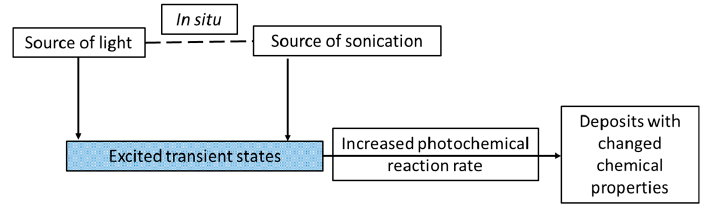
Figure 13. A schematic representation of the synthesis of the materials by means of the sonophotodeposition method.